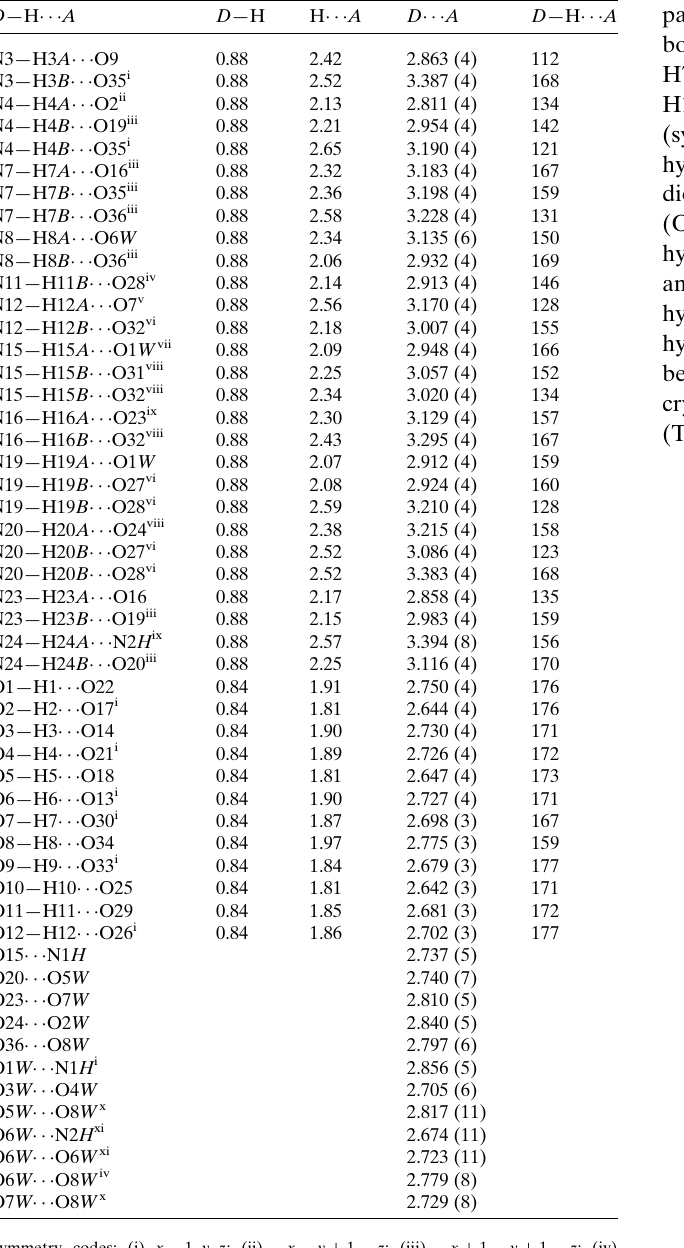
dinating O atoms from the oxalate ligands as acceptor groups. The formed pillars delimit two types of channel propagating